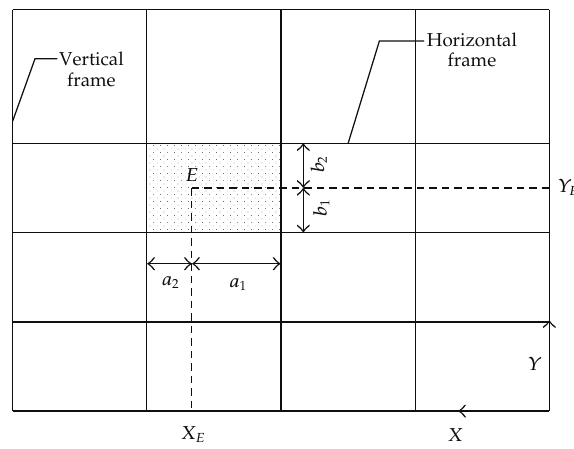
Figure 12: Definition of the main dimensions of SE1.